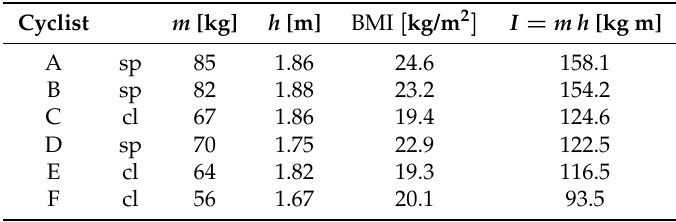
Figure 6. Diagrams of the upper limit cadence C lim (obtained by minimizing EMCF) versus anthropometric properties for different power outputs. Table 3. Anthropometric data of six professional cyclists considered for simulations (sp: sprinter, cl: